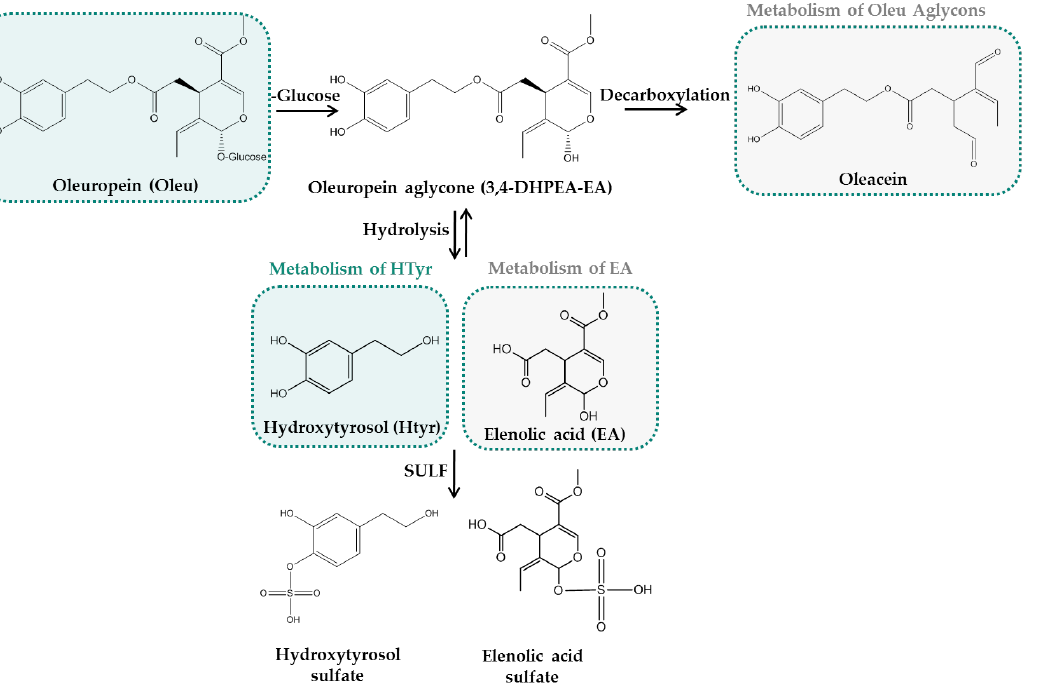
Figure 4. Metabolism of oleuropein (Oleu) in in vivo systems. The gray squares represent the parts of secoiridoids that are neglected so far.